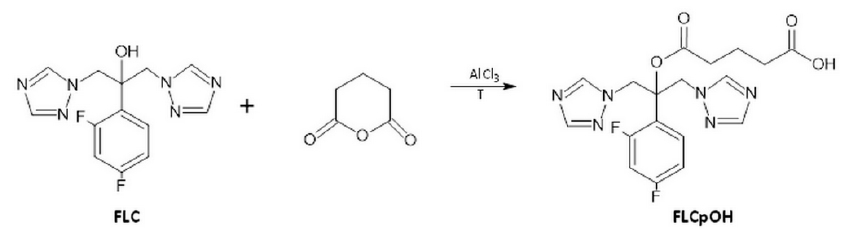
Figure 5. Scheme of the synthesis of fluconazole derivative (FLCpOH) (reaction conditions: AlCl3, 120 °C, 45 min).